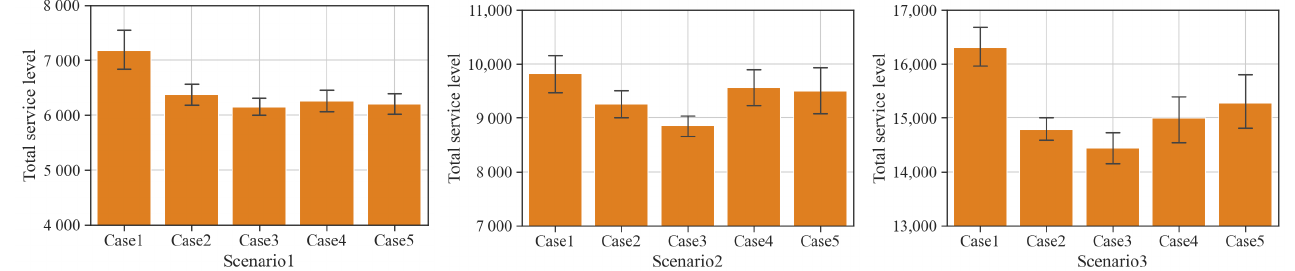
Figure 12. Total service level of each shelter in each scenario. The values are averages of 10 training trials, and the error bars represent 95% confidence